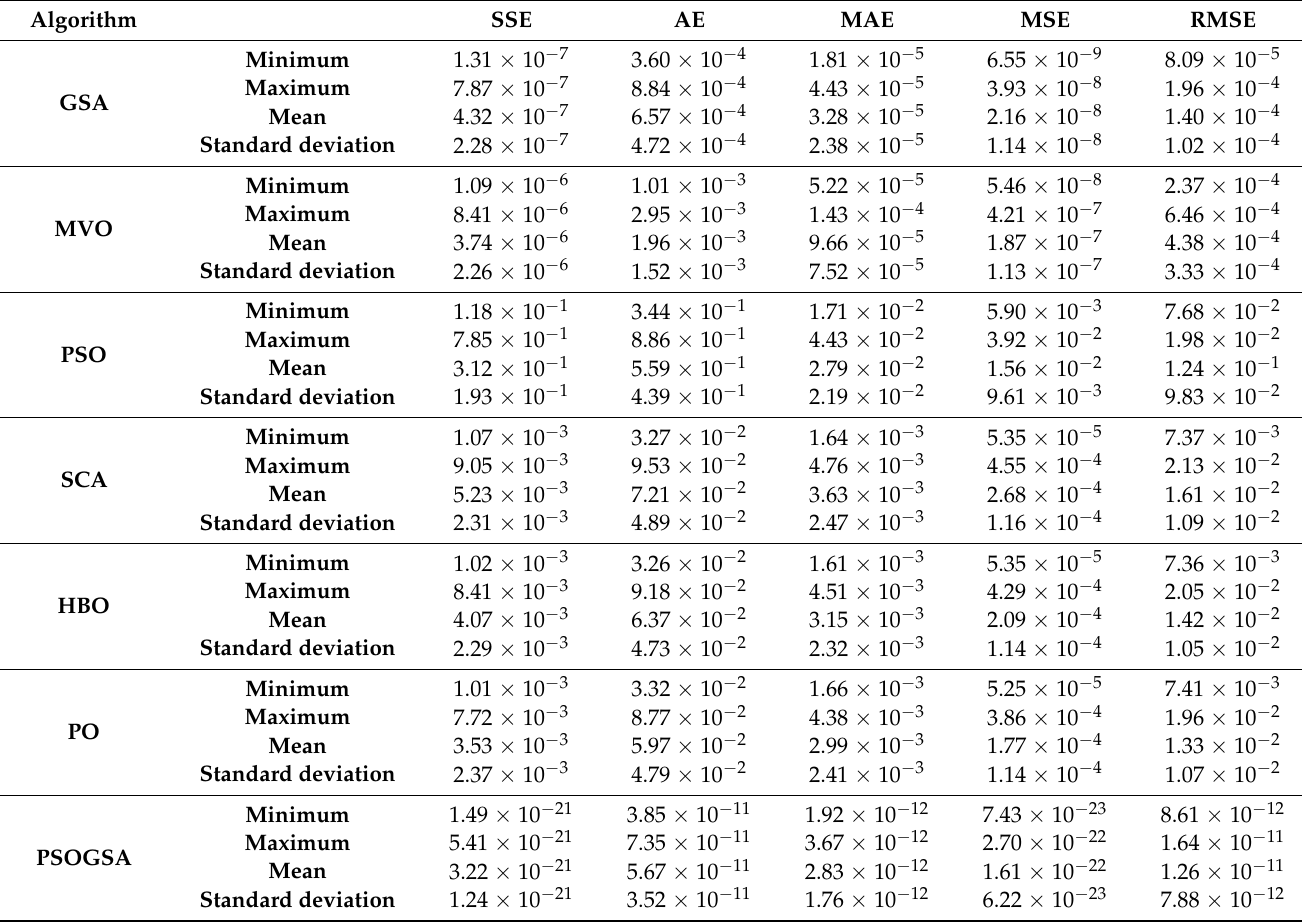
Table 5. The MSDM calculation error, mean and standard deviation for the monocrystalline PV cell.